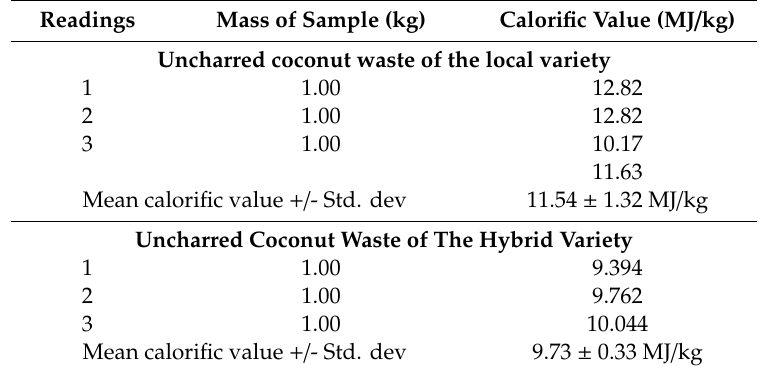
Table 2. Calorific values of local and hybrid varieties of uncharred coconut waste (husk and shell) . Readings Mass of Sample (kg) Calorific Value (MJ / kg) Uncharred coconut waste of the local variety 1